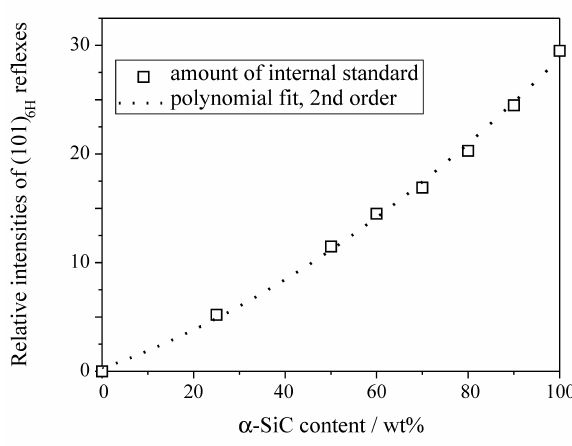
Figure 7. The time-temperature- gas pressure schedule of the furnace sintering of the materials.